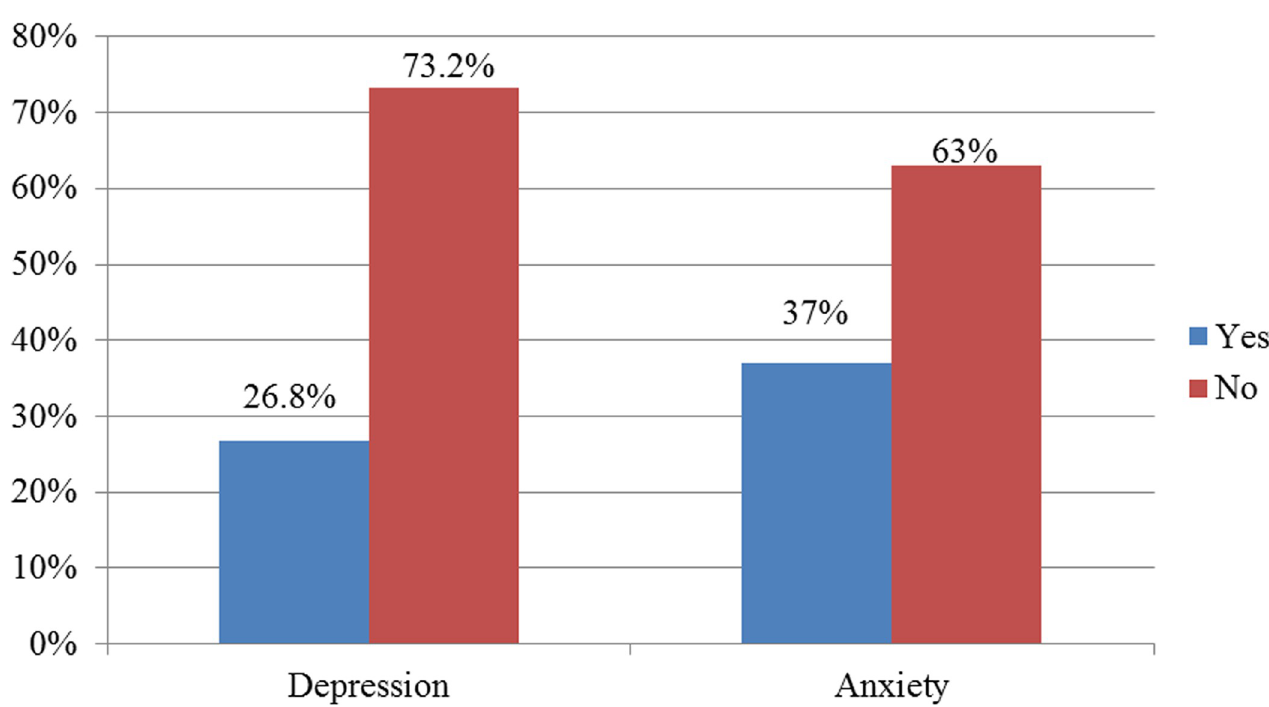
Fig 1. Prevalence of depression and anxiety among chronic disease patients, at selected public hospitals of Sidama regional state, Ethiopia, 2020 (N = 422).